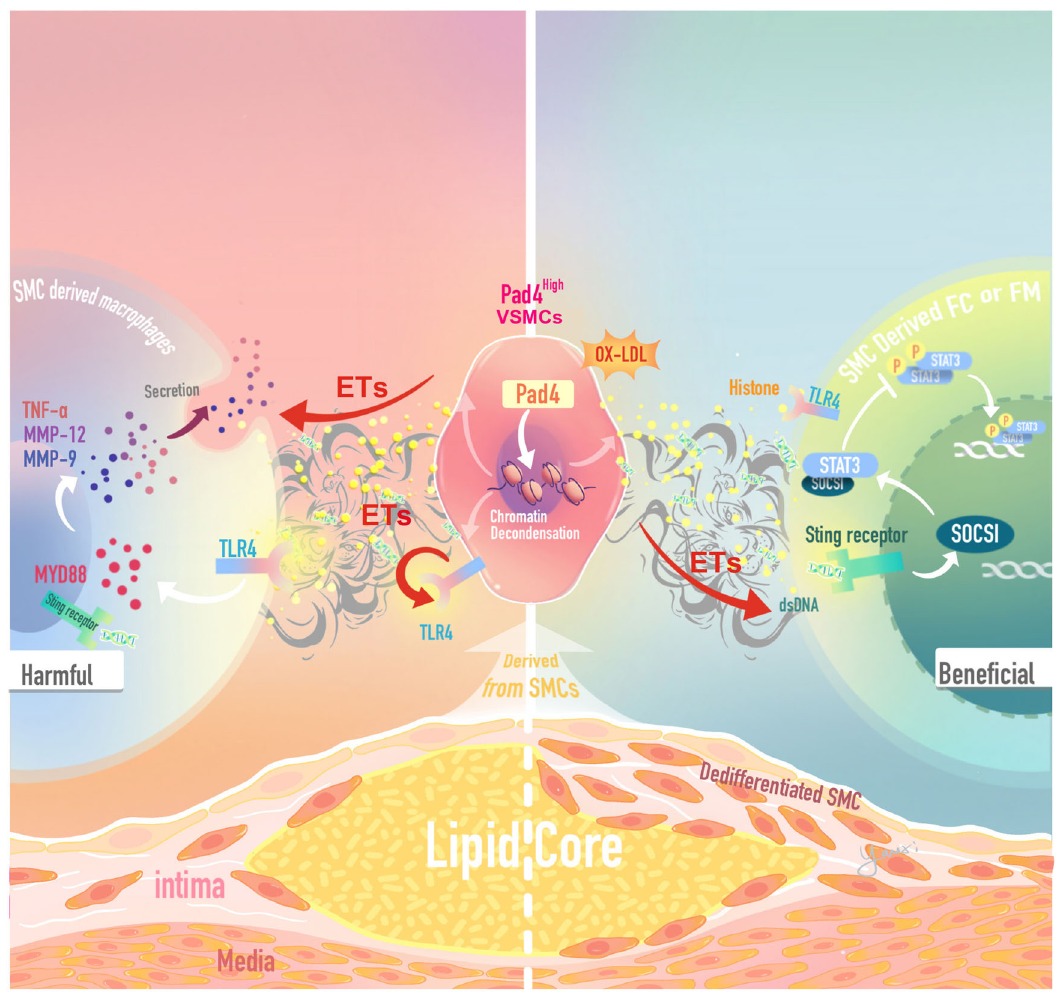
Fig. 6 | Mechanism diagram: PAD4 (hi) CD68 + VSMCs could activate sur- rounding VSMCs by releasing ETs. PAD4 (hi) CD68 + VSMCs released ETs pre- ferentially contributed to trans-differentiation of VSMCs to CD68 + VSMCs and increased collagen degradation, rather than VSMCs ’ trans-differentiation into Fibrochondrocyte (FC) or Fibromyocyte (FM) to stabilize plaques. The ETs acti- vated the STING-SOCS1 signaling pathway, and TLR4-MYD88 signaling pathway of